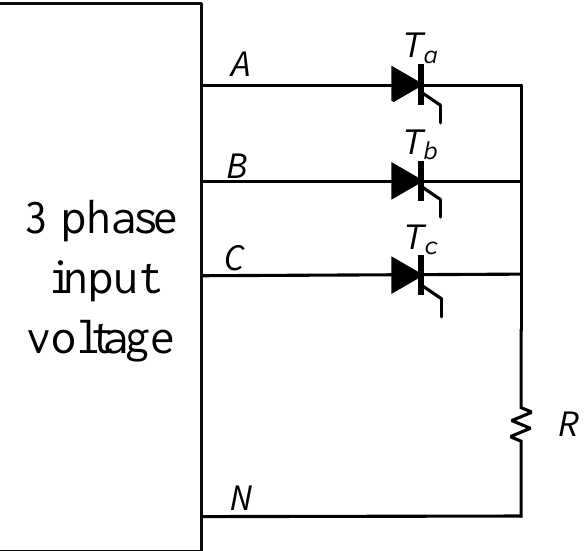
Figure 12. Three-phase half-wave fully controlled